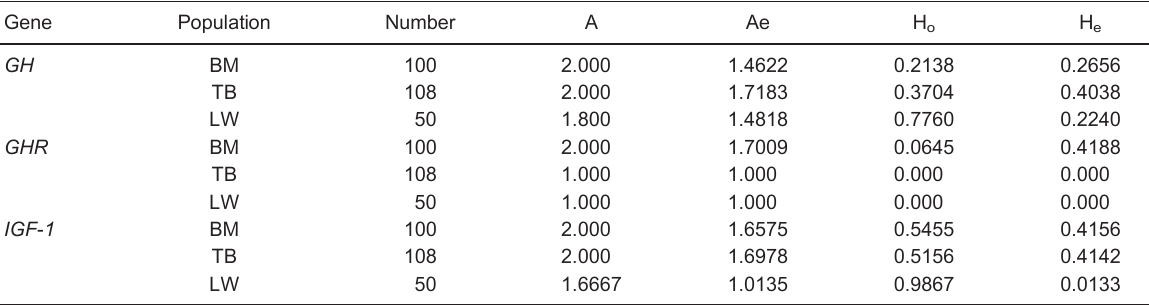
Table 4. Genetic diversity of GH , GHR , IGF-1 genes in 3 pig